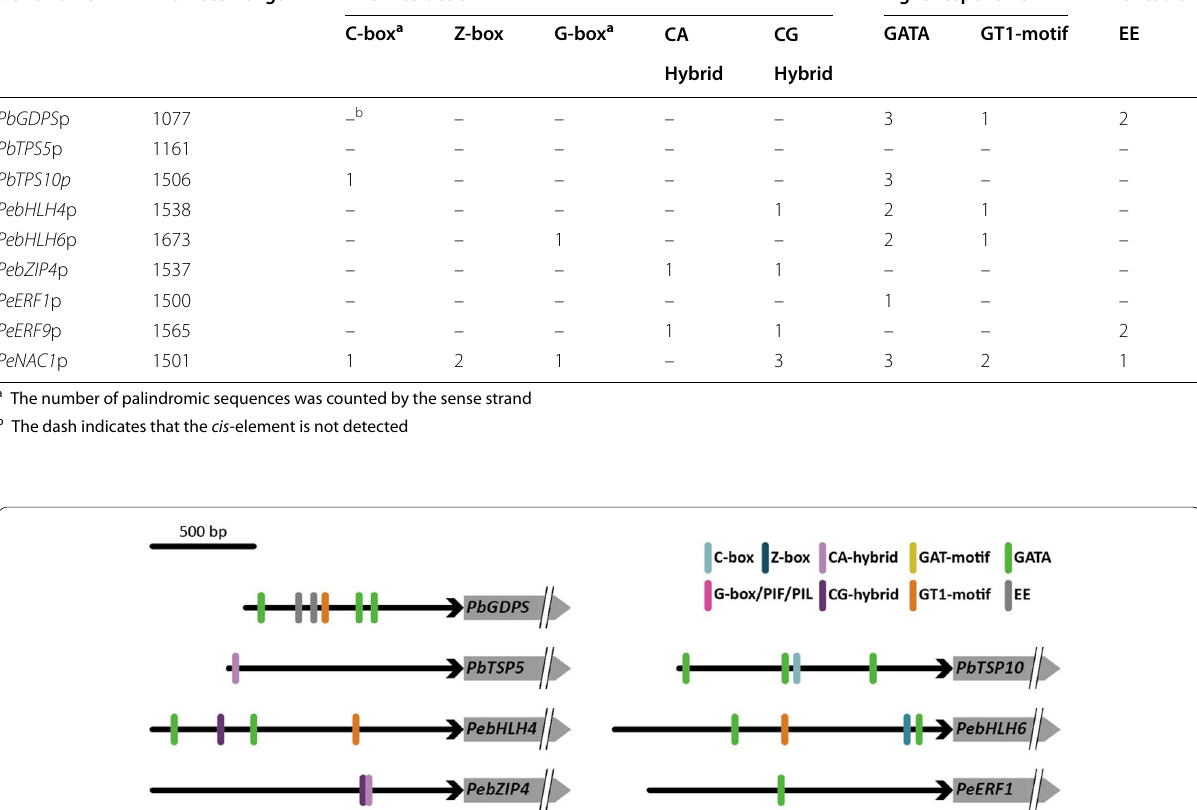
Table 1 c is -elements on the promoter fragments of scent-related structural genes and TFs